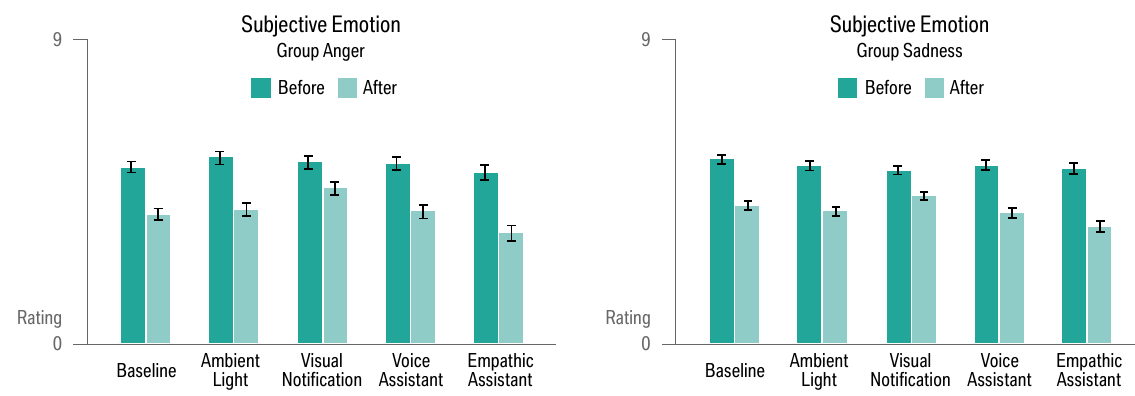
Figure 6. Subjective strength of the induced emotion rated before and after experiencing the influencing strategy.